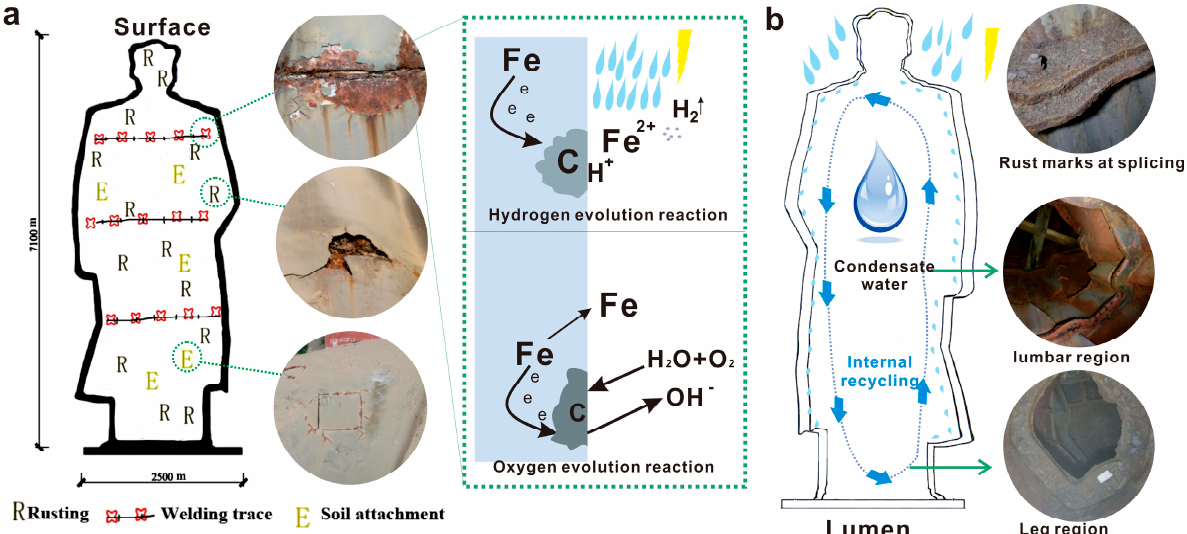
Figure 6. The degradation mechanism of the Chairman MAO Statues in outdoor environment. Corrosion mechanism ( a ) and Condensate water circulation in the cavity of the Statue ( b ).